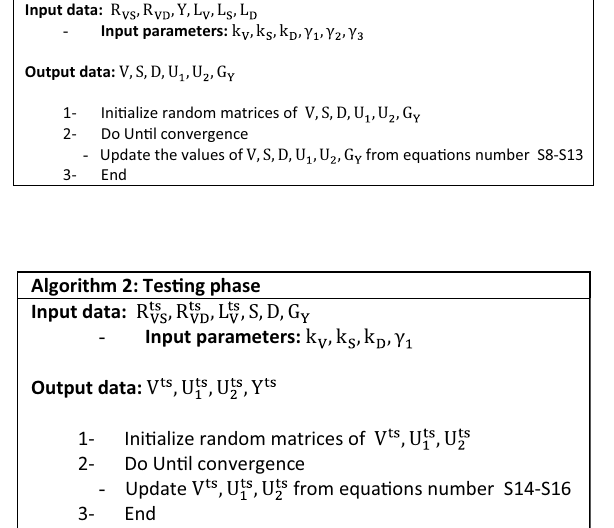
Algorithm 1: Training phase Input data: R ,R ,Y,L ,L ,L